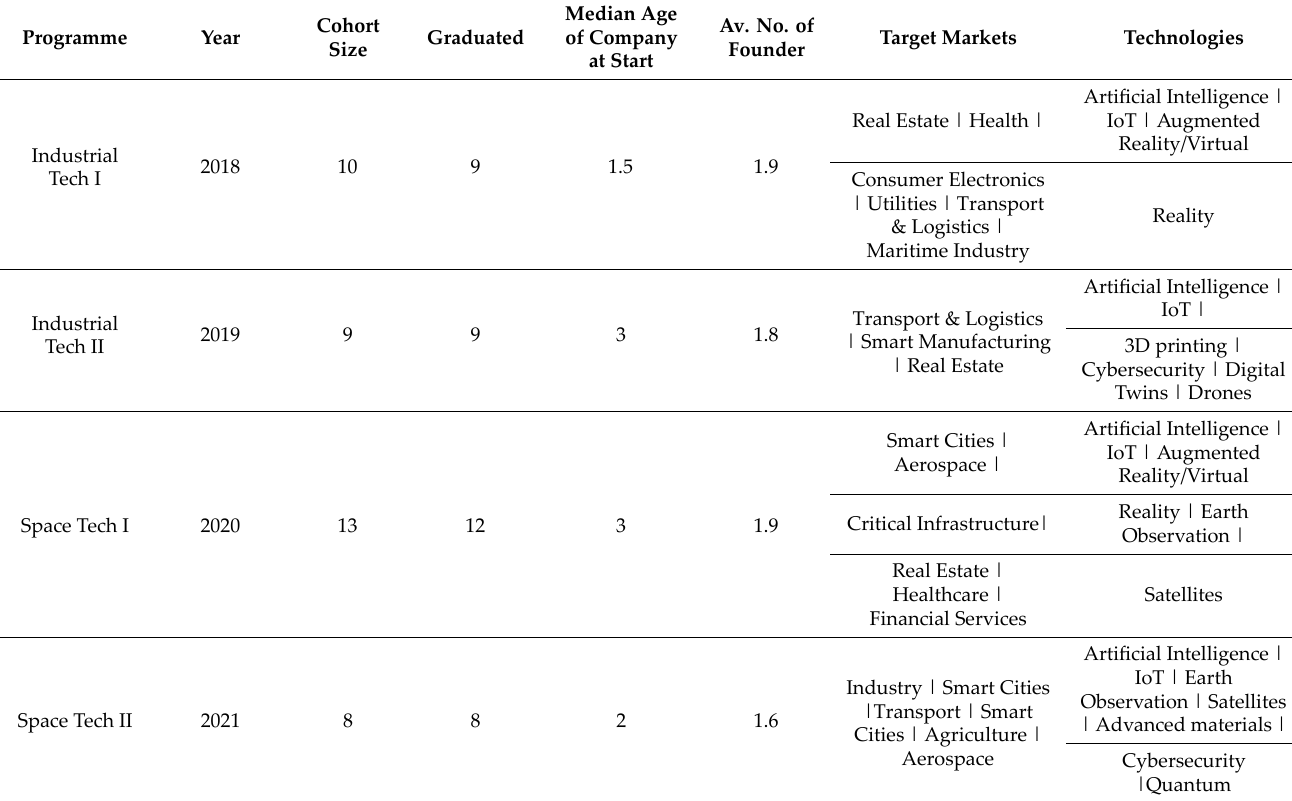
Table 4. Main European Hubs ranked by number of start‑up accelerator